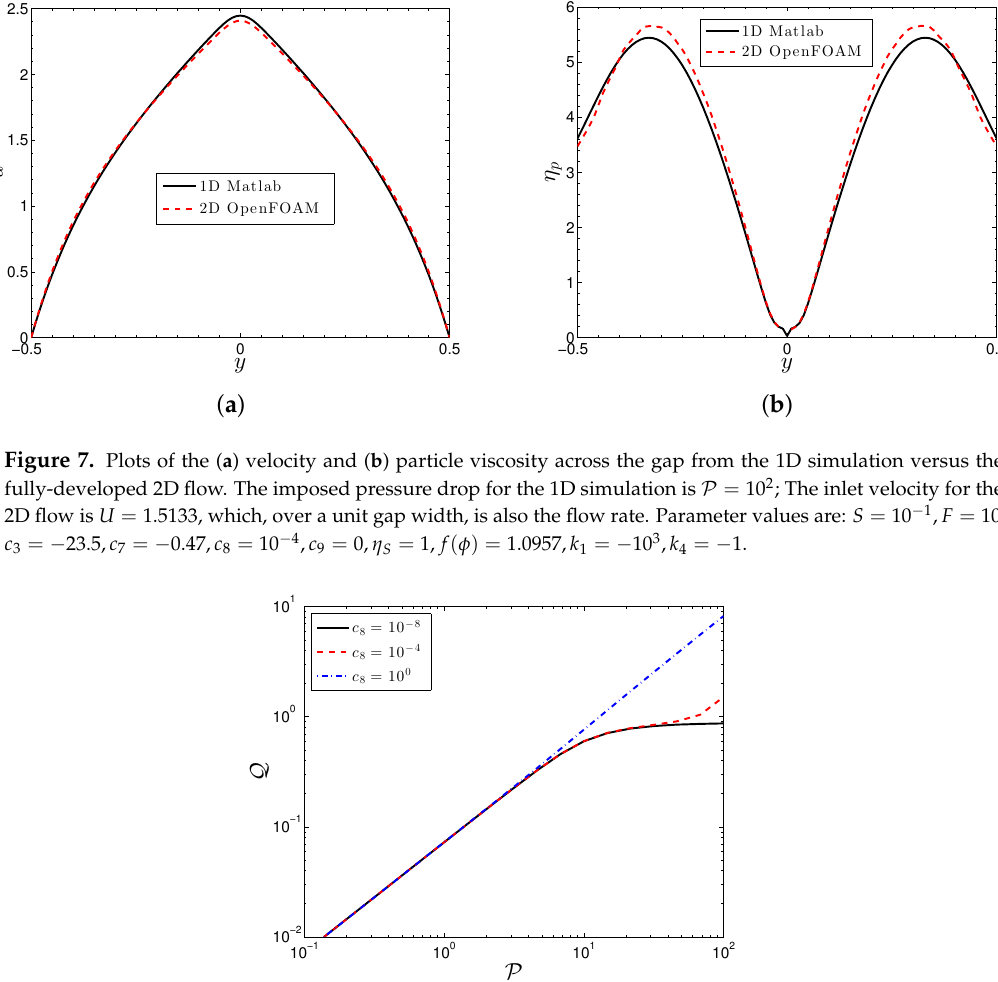
Figure 8. Computed volumetric flow rate, Q , as a function of imposed pressure drop, P . Parameter values are: S = 10 − 1 , F = 10, c 3 = − 23.5, c 7 = − 0.47, c 8 = 10 − 4 , c 9 = 0, η S = 1, f ( φ ) = 1.0957, k 1 = − 10 3 , k 4 = −